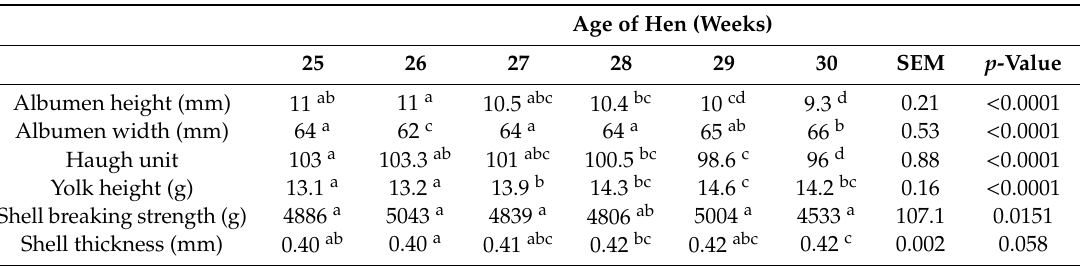
Table 5. Changes in egg quality indices of individually caged ISA Brown hens between 25 and 30 weeks of age ( n =